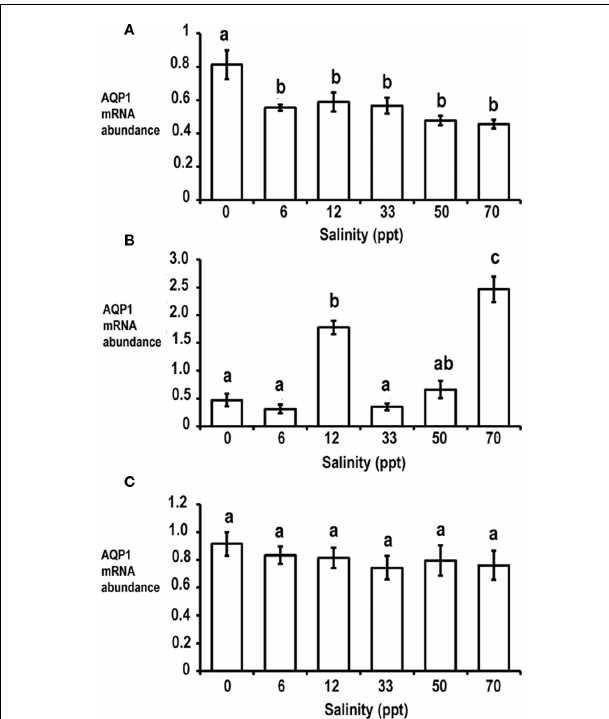
FIGURE 4 | Expression ofAQP1a transcript in gill (A), intestine (B), and kidney (C) following an abrupt transfer of silver sea bream. Two transfers were performed, a 33- to 6-ppt abrupt hypoosmotic transfer and a control 33–33ppt transfer. Data is presented as normalized AQP1a transcript abundance (arbitrary units) and values are expressed as mean ± SEM ( n = 7 − 4).There was no significant interaction between salinity and time ( p <